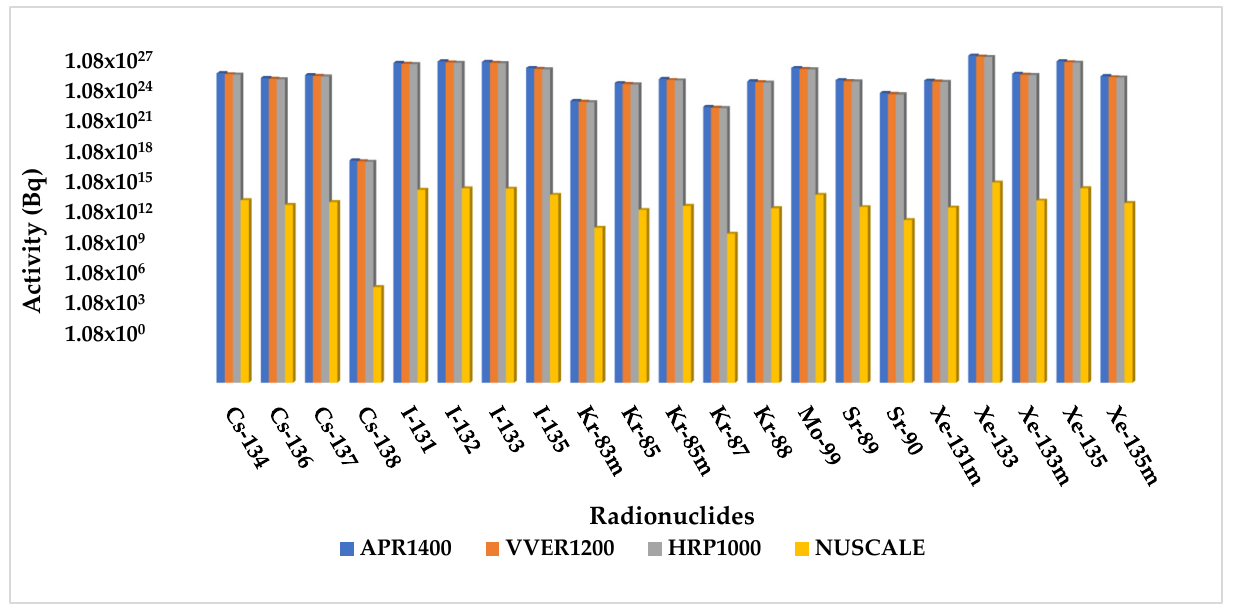
Figure 7. Radionuclide source term comparison for APR100, VVER1200, HPR1000, and Nuscale during Long-term Station Blackout Accident.